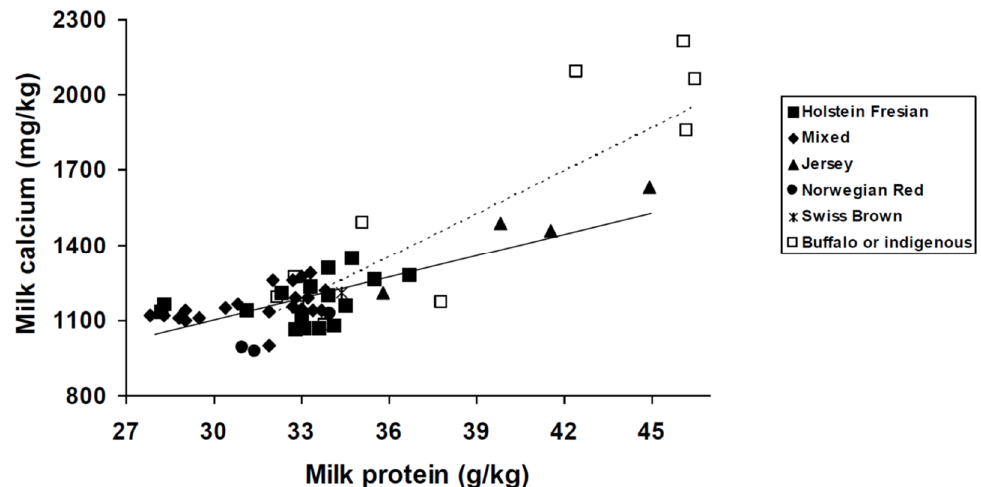
Figure 2. Relationship between milk calcium and protein contents in cows of various breeds and milking potential. Regression equation is: (Milk calcium) = 249 ± 163.0 + 28.4 ± 4.93 * (Milk protein) for the pooled dairy breed (solid line) − 1256 ± 272.03 + 38.0 ± 7.36 * (Milk protein) for the pooled buffalo and indigenous breeds (dotted line). The R 2 = 0.847 and SE was 108.0 mg/kg for this relationship ( p < 0.001). There was no effect of breed within the dairy breeds but the intercept was lower ( p <0.001) and the slope greater ( p < 0.001) for the pooled buffalo and indigenous breeds of cattle. References include [31,35,37,40–59] and the present study. Some references may have more than one data point depending upon treatment groups or breeds.